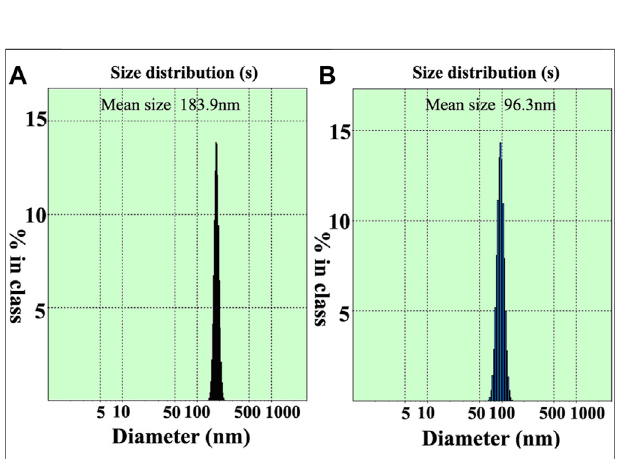
FIGURE 3 | Particle size and its distribution: (A) unmodi fi ed Fe 3 O 4 and (B) OA-Fe 3 O 4 .